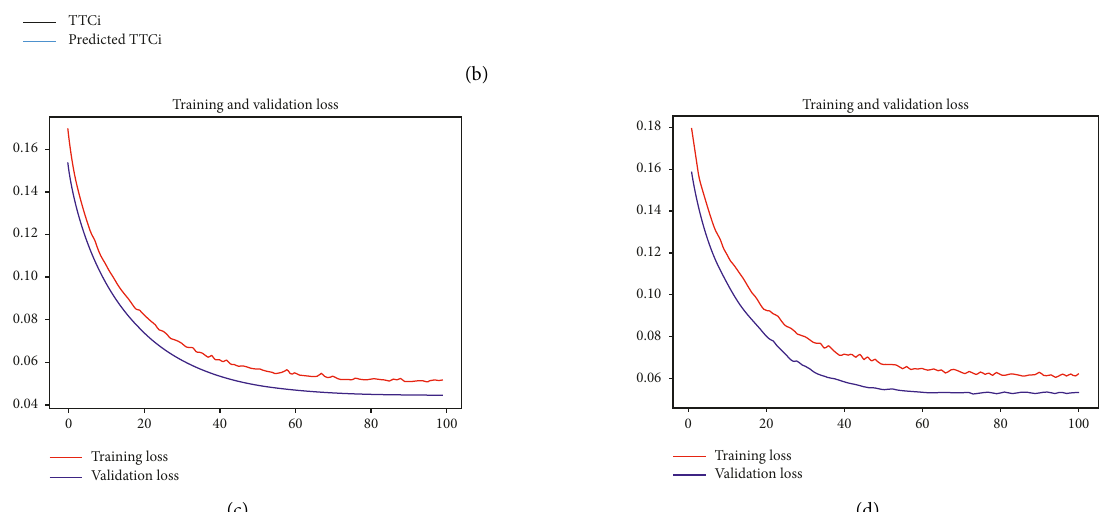
Figure 8: The prediction TTC and real TTC: (a) DBN prediction, (b) LSTM prediction, (c) the LSTM loss function, and (d) the DBN loss